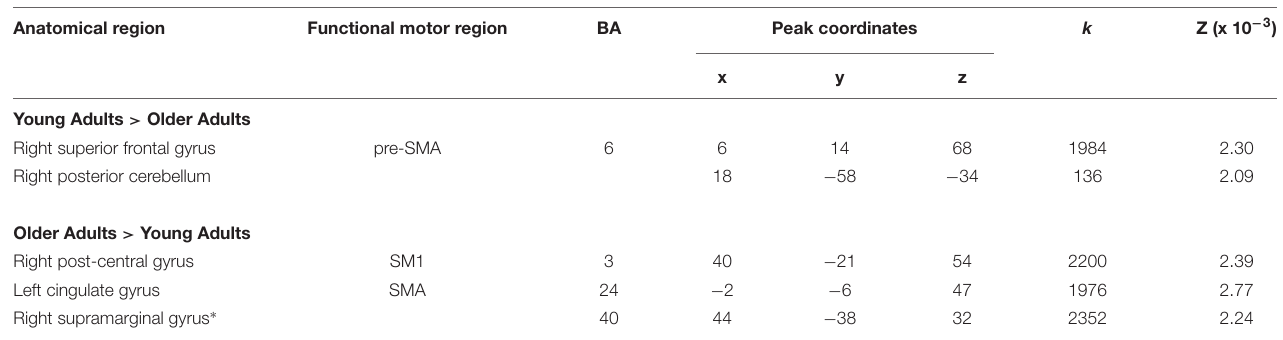
TABLE 5 | Activation likelihood estimation peaks for between-group contrasts for right hand movements. Anatomical